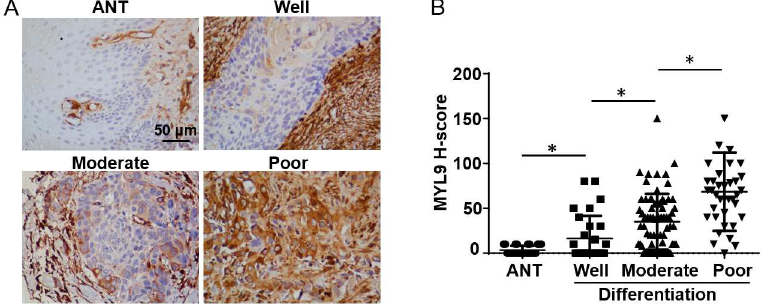
Fig 3. Association between MYL9 expression levels and tumor differentiation. Representative staining of MYL9 expressionin adjacent noncancerous tissue (ANT) and in well-, moderately, and poorly differentiated tumors. Scale bar = 50 μ m. (B) The averageMYL9 stainingscore was increasedfrom well-differentiated to poorly differentiated tumors, and was significantly higherthan that in ANT regions. IHC H-scores are expressedas the mean ± SD (bars); * p <